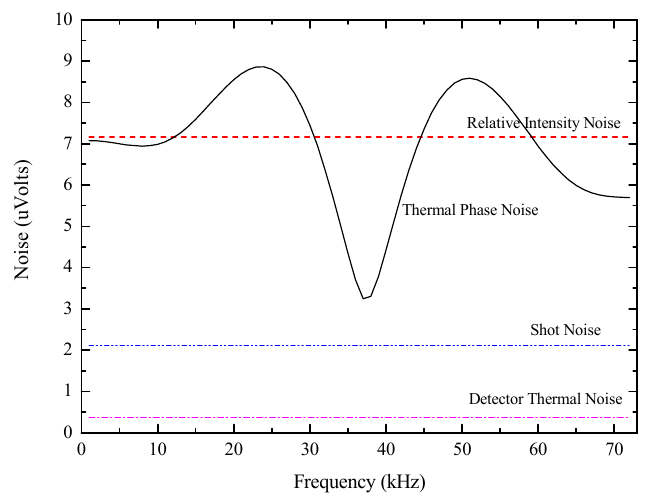
Figure 6. Calculated noise voltages for the solid core photonic crystal fiber-optic gyroscope.